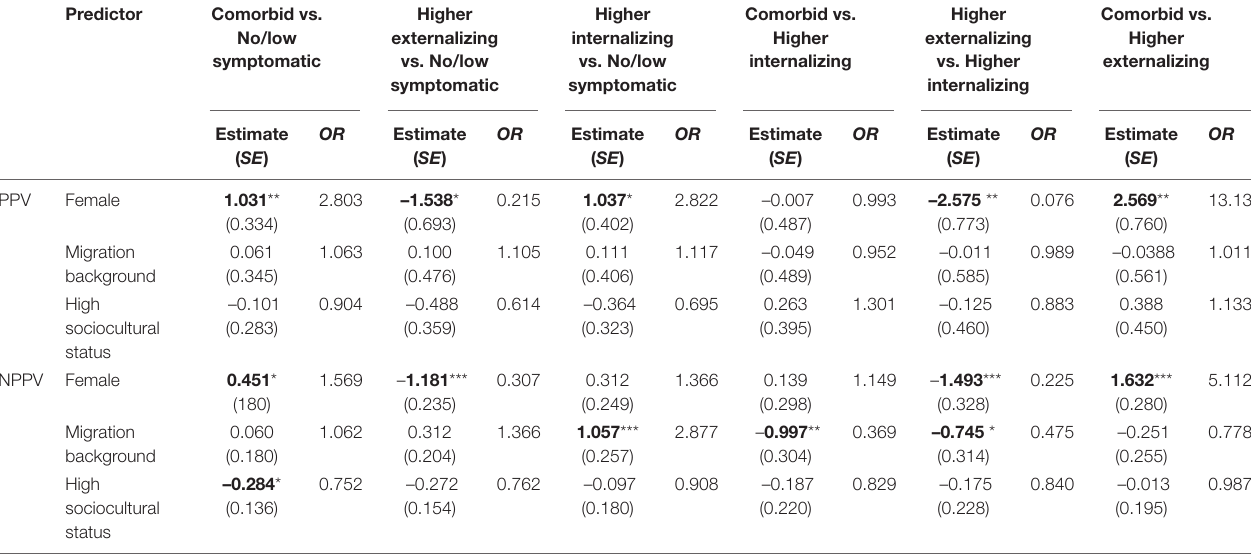
TABLE 5 | Three-step multinomial logistic regression analysis with sociodemographic